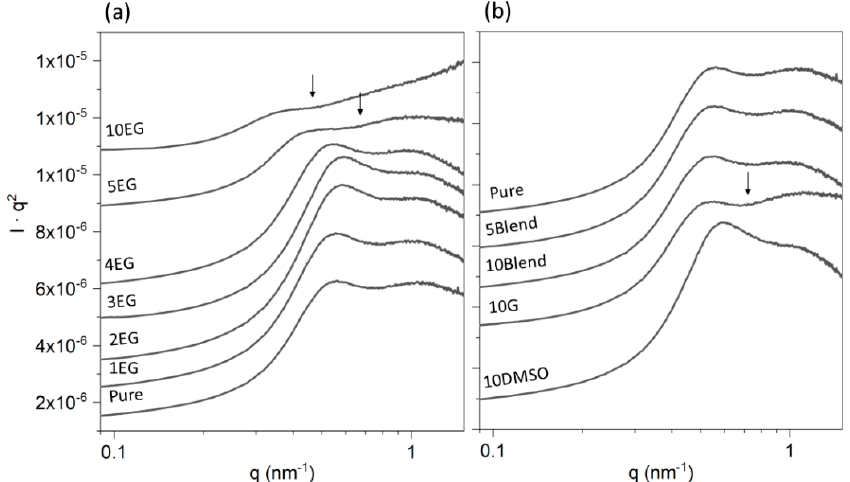
Figure 2. Kratky plots calculated from the SAXS intensity profiles of PEDOT:PSS with EG ( a ) and with G, with DMSO and G+DMSO ( b ), at different wt.% as labelled. The arrows highlight the onset for the upturn of intensity. X-axis are shown in logarithmic scale. The profiles are shifted vertically for clarity.